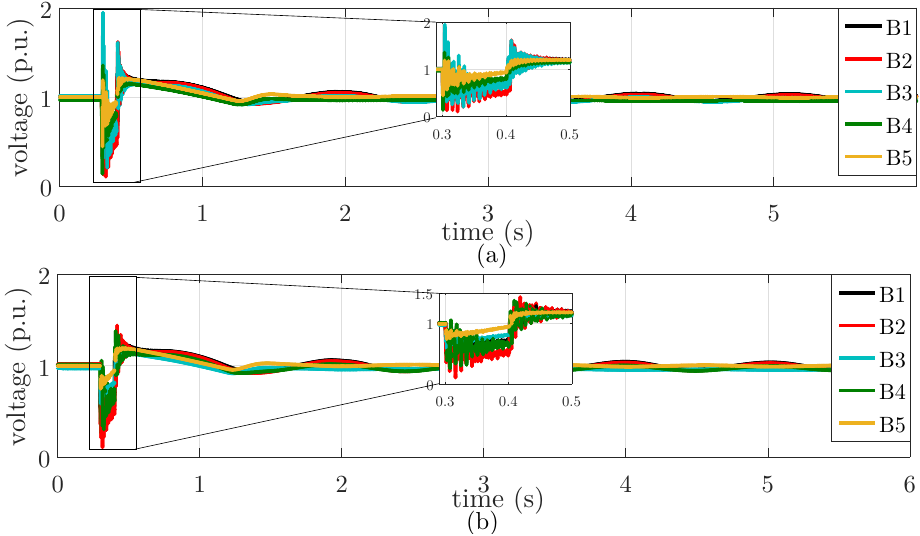
Figure 4. Voltages in the buses of the power system: ( a ) RTDS. ( b ) DIgSILENT PowerFactory.